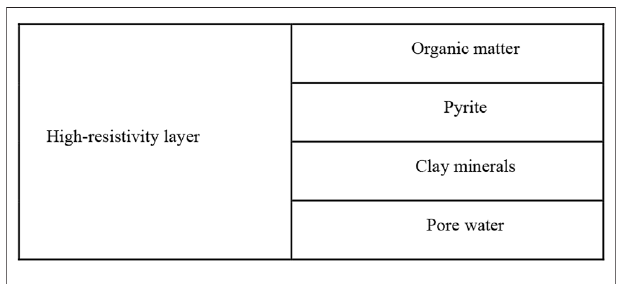
FIGURE 14 | Shale conductivity model.